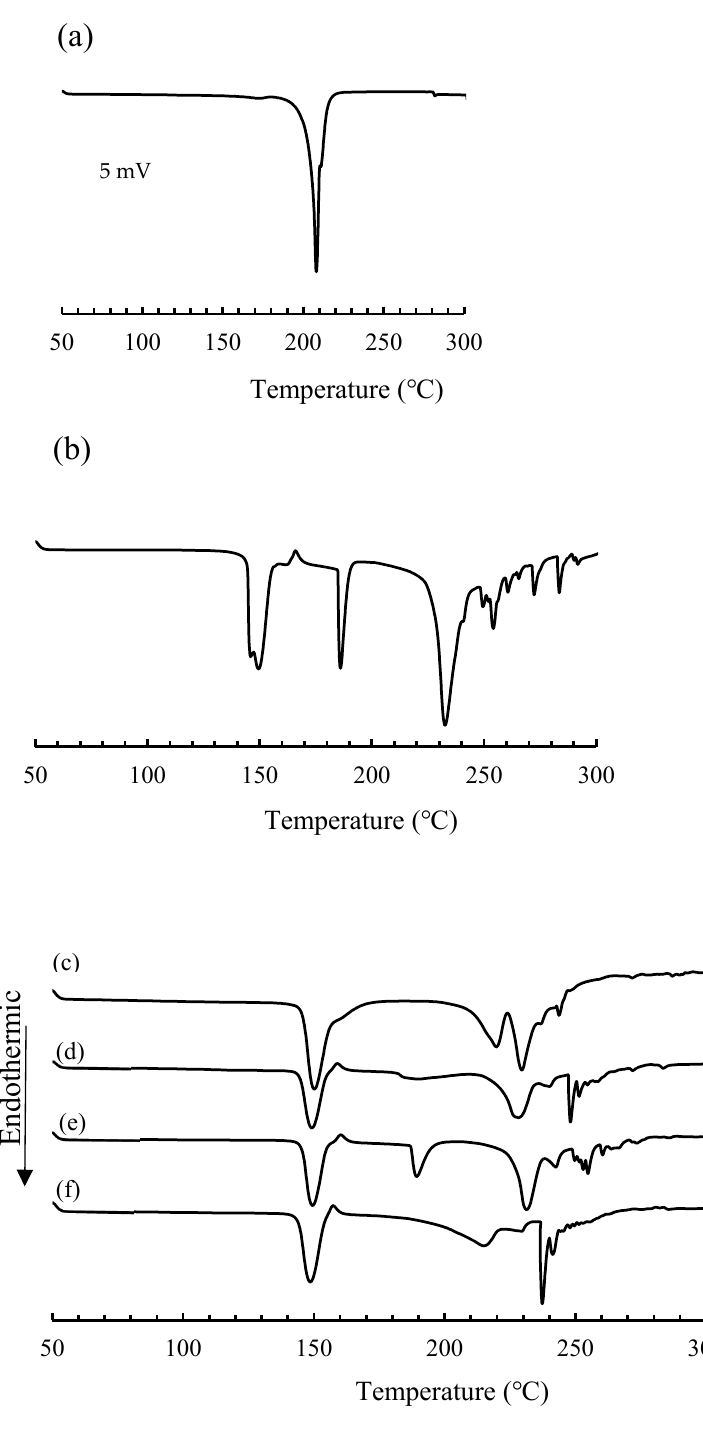
Figure 5. DSC curves of various samples. ( a ) Baclofen crystals, ( b ) lactose, ( c ) baclofen powder just after the preparation, ( d ) baclofen stored in the closed-bottle condition for 60 days, ( e ) 90 days, and ( f ) 120 days.